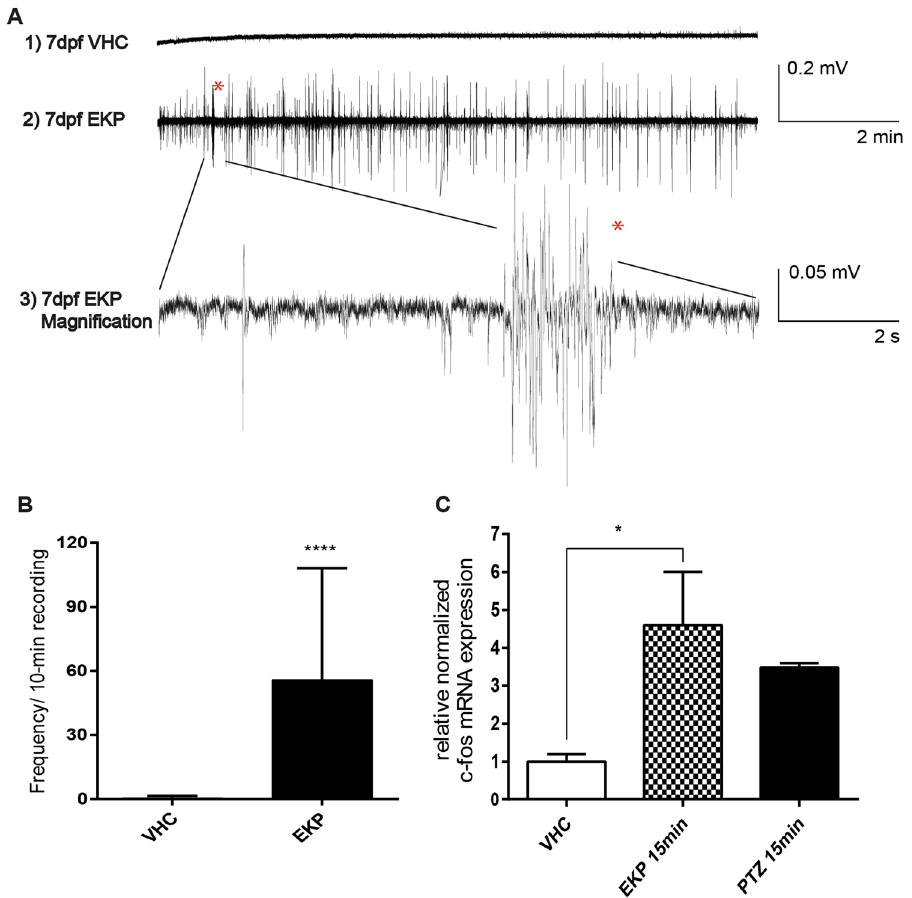
Figure 3. EKP induces abnormal electrographic activities in the optic tectum and c-fos expression in brain of 7 dpf larvae. ( A ) Fragments of representative recordings from 7 dpf larva treated with VHC (A1) or 15 min after application EKP (400 µ M) (A2). Bottom trace (A3) shows a high-resolution magnification of the epileptiform events indicated above. ( B ) Number of epileptiform events in VHC and EKP treated larvae: VHC 0.4857 ± 0.1804 vs EKP 55.76 ± 6.872 events/10 min recording. The number of recordings analyzed were: VHC (n = 35) and EKP (n = 58). Statistical analysis was performed using Student’s unpaired t-test. Values that were significantly different compared to VHC were indicated with **** p ≤ 0.0001. Error bars on all graphs represent s.d. ( C ) EKP-induced seizure upregulated c-fos expression in 7 dpf zebrafish larvae as assessed by qPCR (PTZ was used as positive control). c-fos expression is normalized to the housekeeping gene ef1 α and β -actin 1 . The data were analyzed using the ΔΔ Cq method and reported as mean ± s.e.m. of three experiments performed in